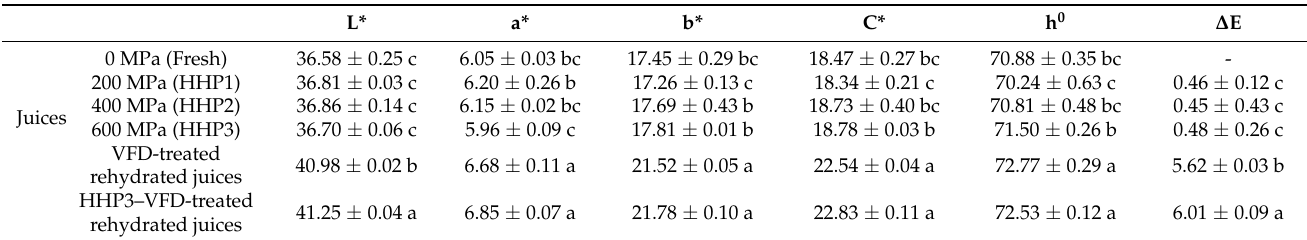
Table 1. Color parameters in blended juice and cubes treated by HHP and